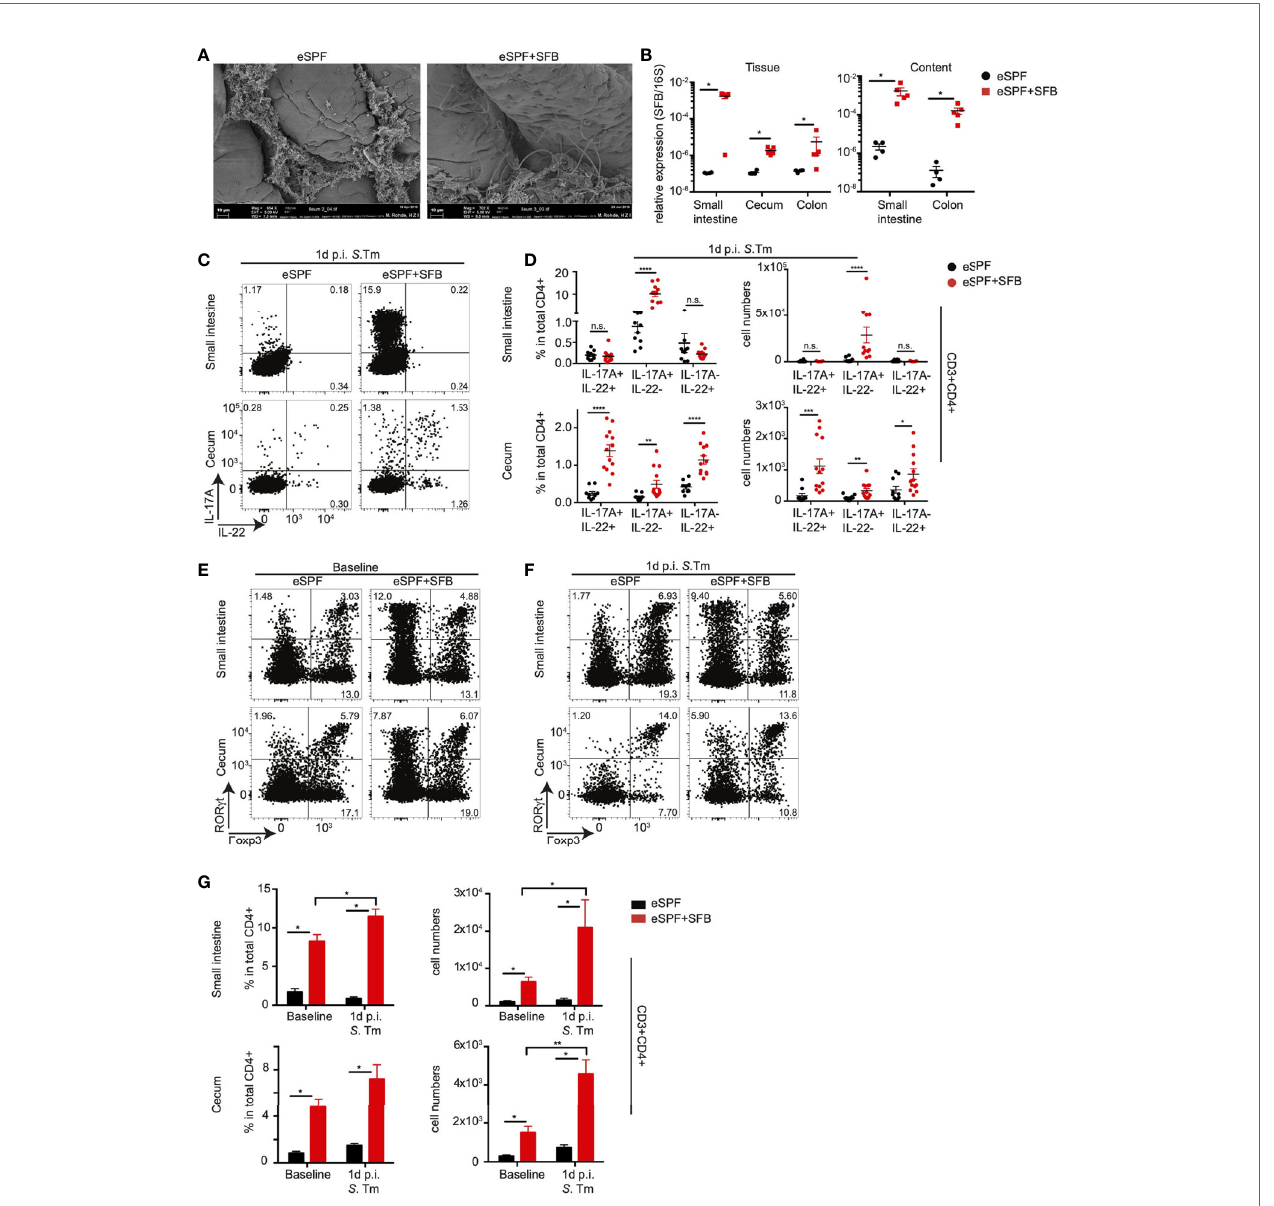
FIGURE 2 | Anti-bacterial IL-17A and IL-22 responses by CD4+ T cells are dependent on SFB. (A) Scanning electron microscopy of ileum samples from eSPF mice with or without cohousing with SFB-monocolonized mice. (B) Relative expression of SFB speci fi c 16S rRNA gene compared to total bacterial 16S rRNA gene in tissues and contents from different parts of intestinal tract in eSPF and eSPF+SFB colonized mice. (C, D) LPL were isolated 1d post S . tm . infection from the small intestine and cecum of IL-17A GFP IL-22 BFP FoxP3 RFP mice harboring eSPF or eSPF+SFB. Representative FACS plots and percentages and absolute numbers of CD3+CD4+ cells expressing IL-17A and IL-22 without restimulation. (E – G) LPL were isolated during steady state and 1d post S . tm. infection from small intestine and cecum of ROR g t GFP FoxP3 RFP mice harboring eSPF or eSPF+SFB. Representative FACS plots (E, F) and percentages and absolute numbers (G) of CD3+CD4+ cells expressing ROR g t and Foxp3. Data represent n = 5 – 13 mice/group as mean ± SEM from at least two independent experiments. P-values indicated represent an unpaired Student ’ s t test *p < 0,05; **p < 0,01; ***p < 0,001; ****p < 0,0001; n.s., not signi fi cant. See also Supplementary Figure S2